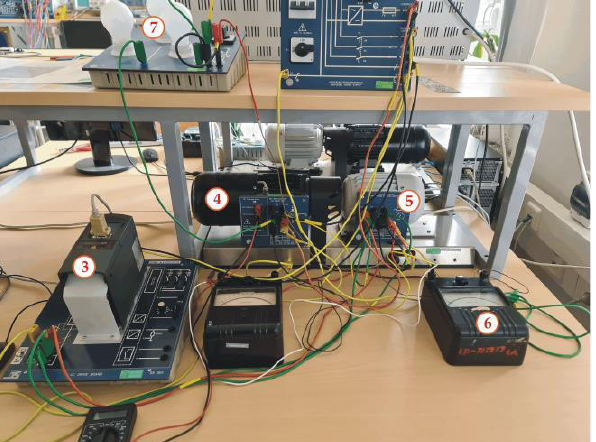
Figure A9. Photo of experimental setup for the reactive power provided or drawn out by Siemens Micromaster 420 single-phase diode rectifier supply-side VFD analysis.